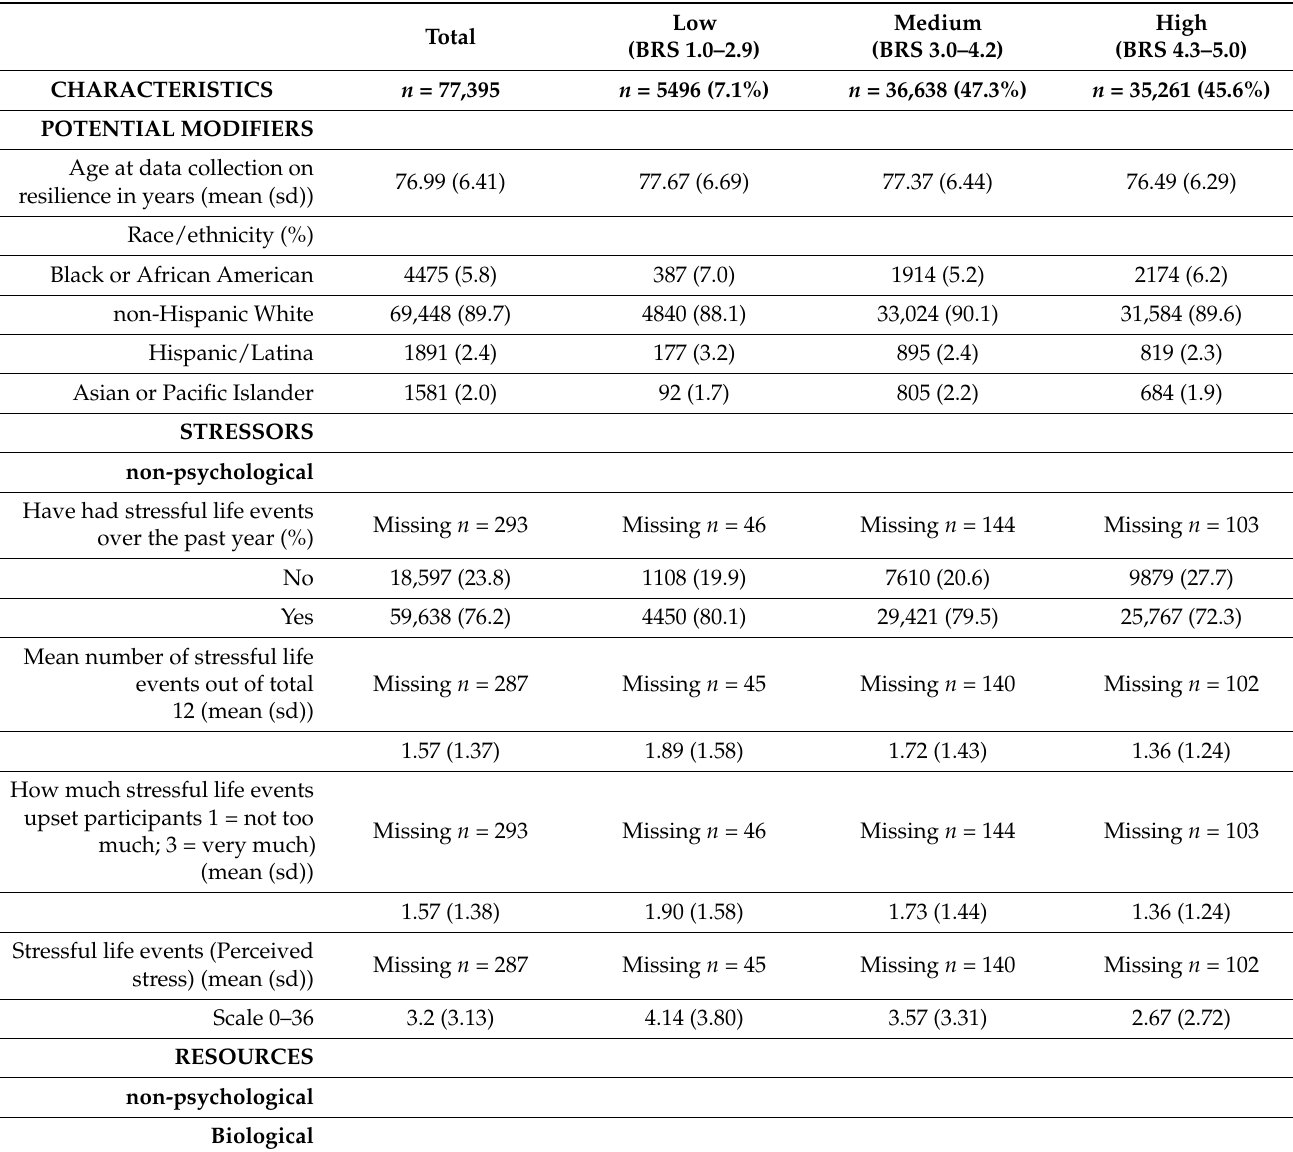
Table 2. Demographics, stressors, resources (non-psychological and psychological) by self-reported psychological resilience from participants in the Women’s Health Initiative Extension Study. Low Medium High Total (BRS 1.0–2.9) (BRS 3.0–4.2) (BRS